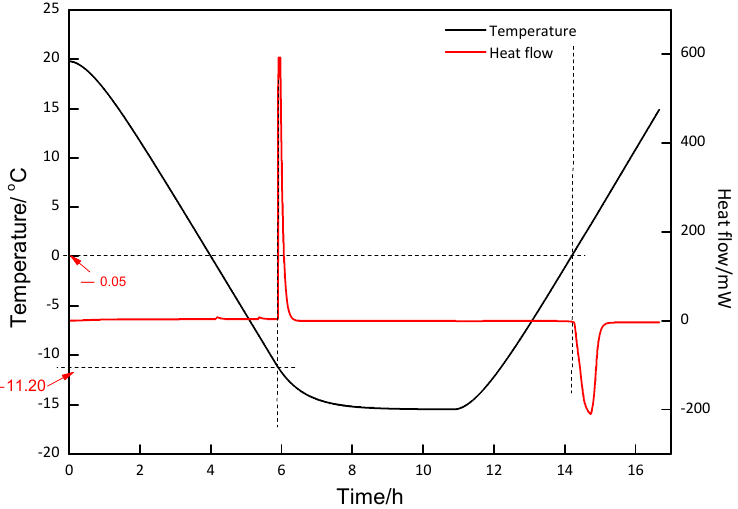
Figure 4. The heat flow and temperature changes vs. time corresponding to the ice formation and melting with the Setaram BT 2.15.